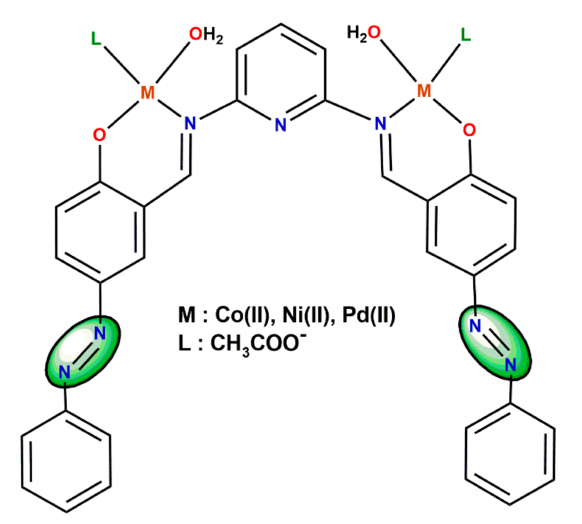
Figure 7. Symmetrical pyridine bridged azo-Schiff base metal complexes for DSSC [46].